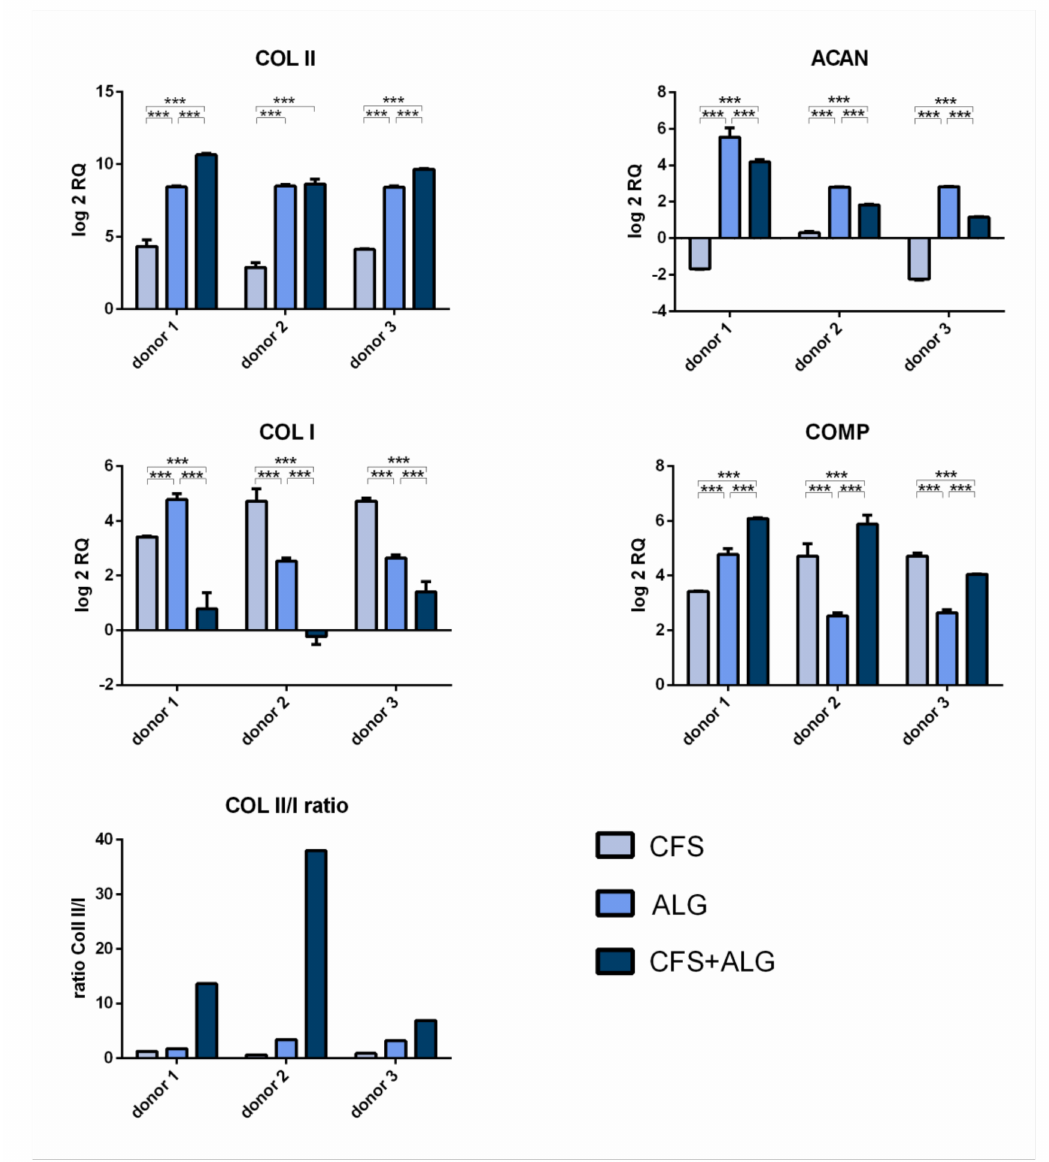
Figure 7. RT-qPCR analyses of mRNA of the chondrogenic genes Collagen II ( COL II ), Aggrecan ( ACAN ), and cartilage oligomeric matrix protein ( COMP ) and the dedifferentiation marker gene collagen I ( COL I ) after differentiation in chitosan flock scaffolds (CFS), alginate hydrogels (ALG), and chitosan/alginate flock scaffolds (CFS+ALG). Relative induction of gene expression was analyzed after 21 days of differentiation relative to GAPDH and human chondrocytes in monolayer culture at the end of expansion in passage 5. Ratios on mRNA levels were calculated from the relative quantification of collagen type II to I ( COL II /I). The results are shown as mean ± SD, n = 3. p -value ***